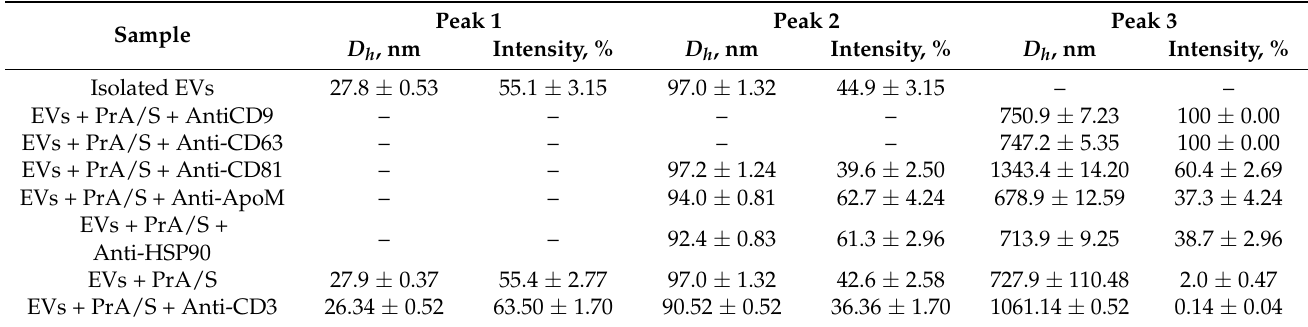
Table 1. Identification of exosomal and exomeral biomarkers by means of dynamic light scattering (DLS) combined with immunoprecipitation